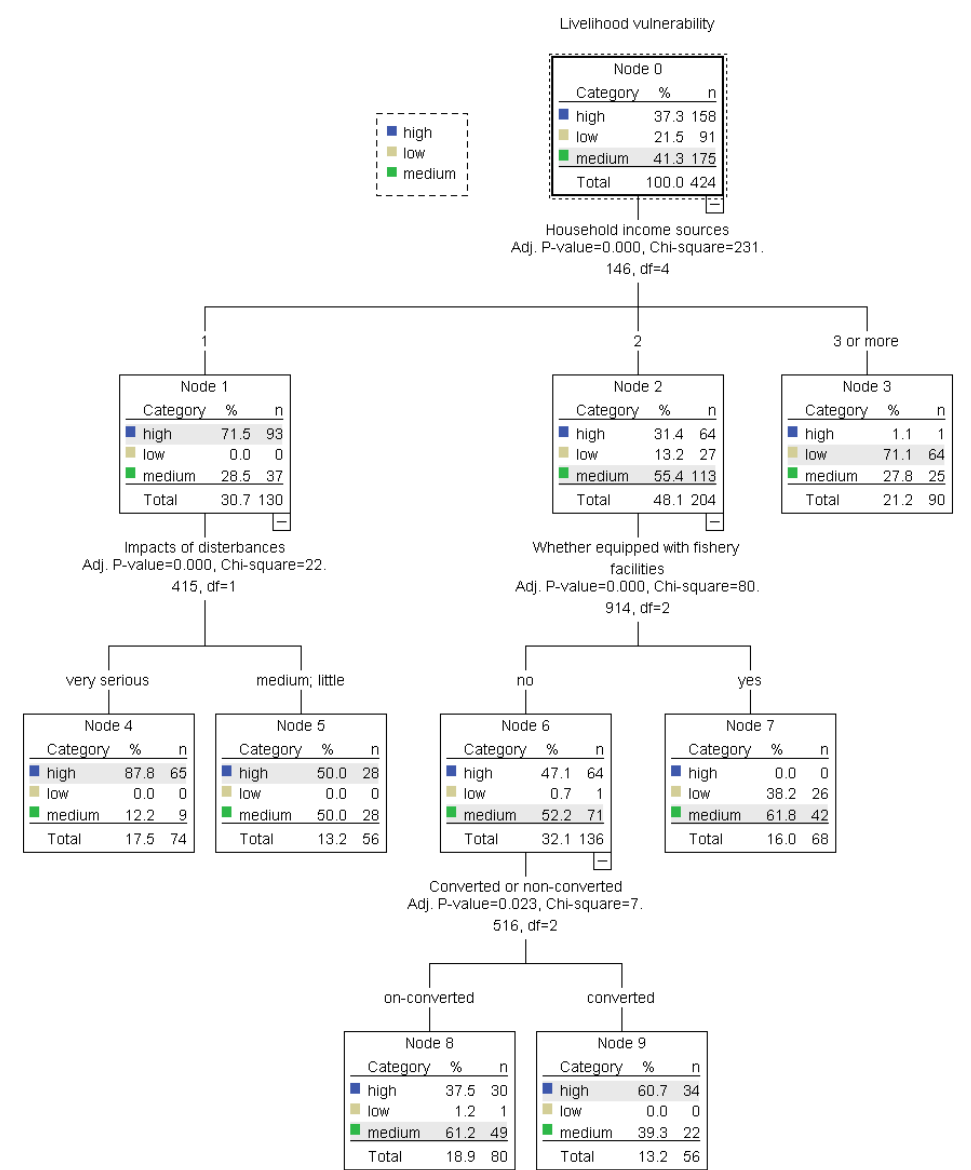
Figure 5. Determinants of marine fishermen’s livelihood